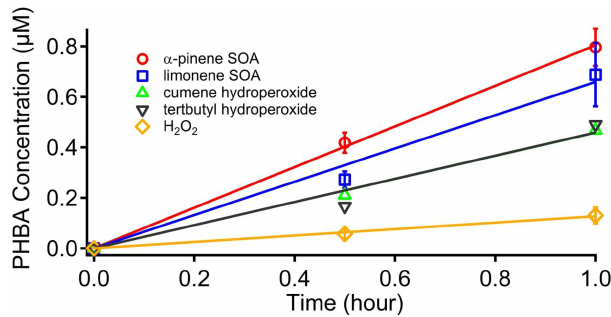
Figure 3. Concentrations of p-hydroxybenzoic acid (PHBA) formed by photolysis experiments for 250µM solutions of SOA and 12.5µM solutions of commercial hydroperoxides. Fits are lines of best fit, forced through the